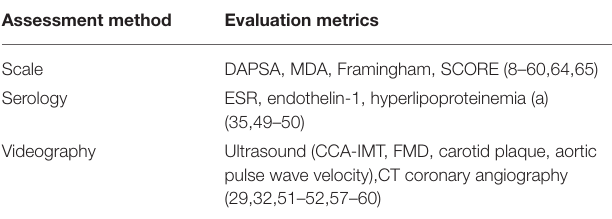
TABLE 1 | Risk assessment of PsA combined with